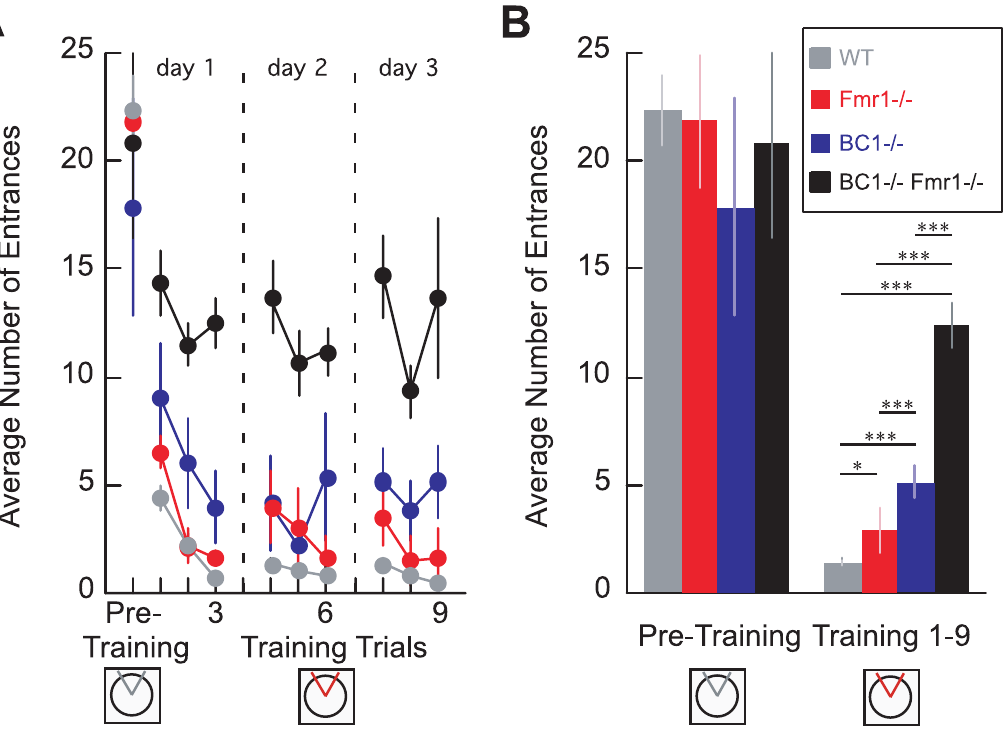
Figure 3. Place learning is mildly impaired in BC1 2 / 2 and Fmr1 2 / 2 sKO mice but severely impaired in BC1 2 / 2 Fmr1 2 / 2 dKO mice. ( A ) Exploration, measured as the number of entrances into a 60 u zone (gray sector on the circle in the schematic), did not differ amongst the groups on the pre-training trial when the shock was off (F 3,26 =0.38; P=0.8). When the shock was turned on (red sector), all groups except the dKO learned to avoid the shock zone. The effects of genotype and trial across place training were significant (genotype: F 3,234 =141.81; P=10 2 52 ; F 8,234 =4.96; P=10 2 5 ) and the interaction was not (F 24,234 =0.70; P=0.85). Newman-Keuls post-hoc tests confirmed that the overall number of entrances significantly differed between all groups (WT , Fmr1 2 / 2, BC1 2 / 2, dKO). The failure of the dKO to learn persisted across 3 days of training (3 trials/day) and this was confirmed by 1-way ANOVA on the factor trial (F 8,45 =1.02; P=0.43). ( B ) Summary of behavior on the pre-training and active avoidance trials illustrates the significant group differences during place learning. Error bars indicate S.E.M., *P , 0.05, ***P , 0.001. BC1 2 / 2 , n=6; Fmr1 2 / 2 , n=6; dKO, n=6; WT, n=12.